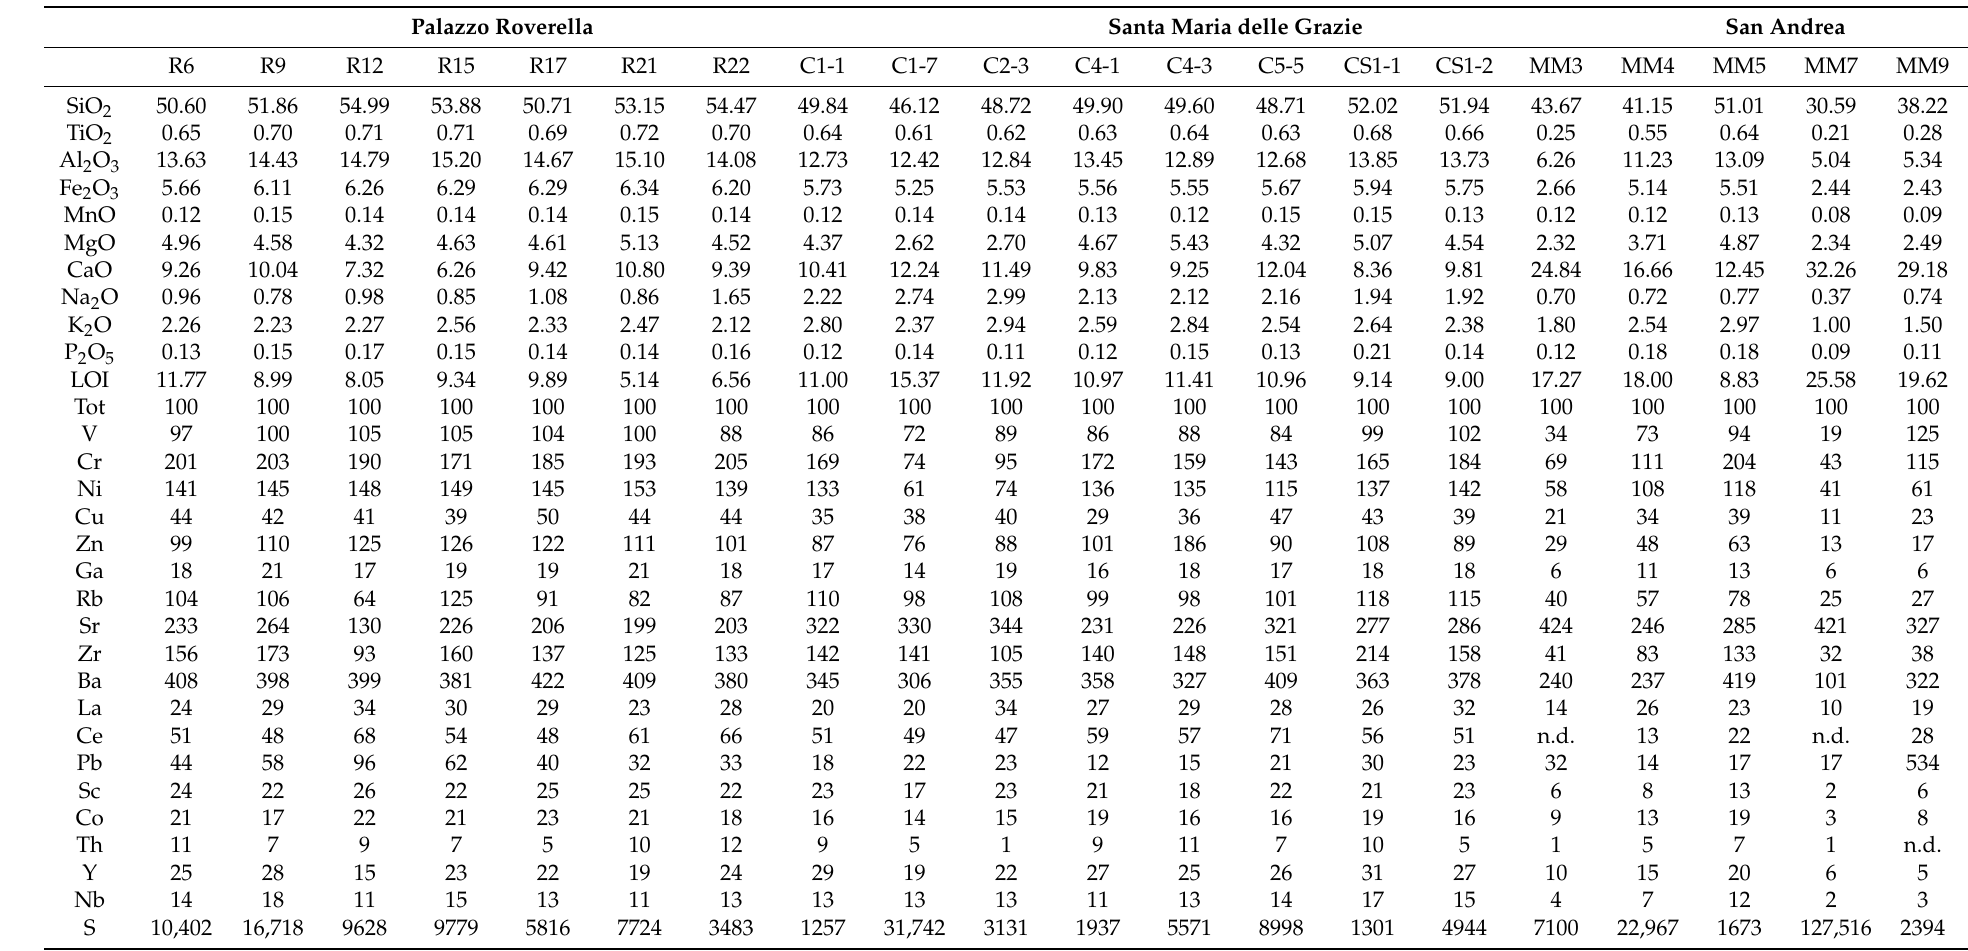
Table 2. XRF data of the major oxides present in the samples analyzed and expressed in weight (%) and the data of the trace elements expressed in ppm (n.d. = not